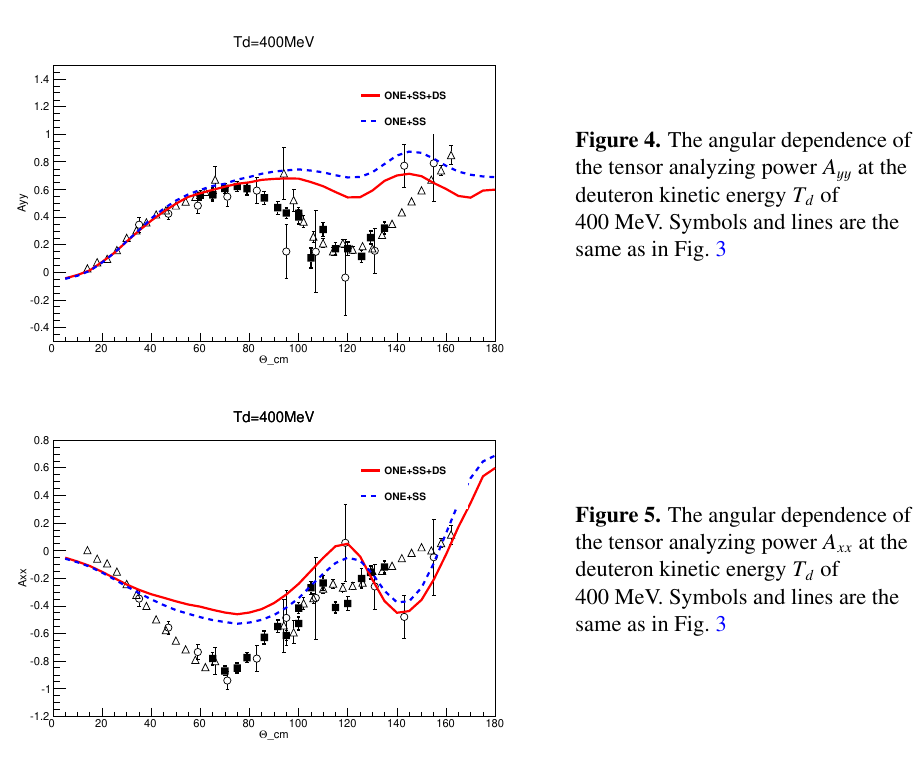
Figure 4. The angular dependence of the tensor analyzing power A yy at the deuteron kinetic energy T d of 400 MeV. Symbols and lines are the same as in Fig. 3